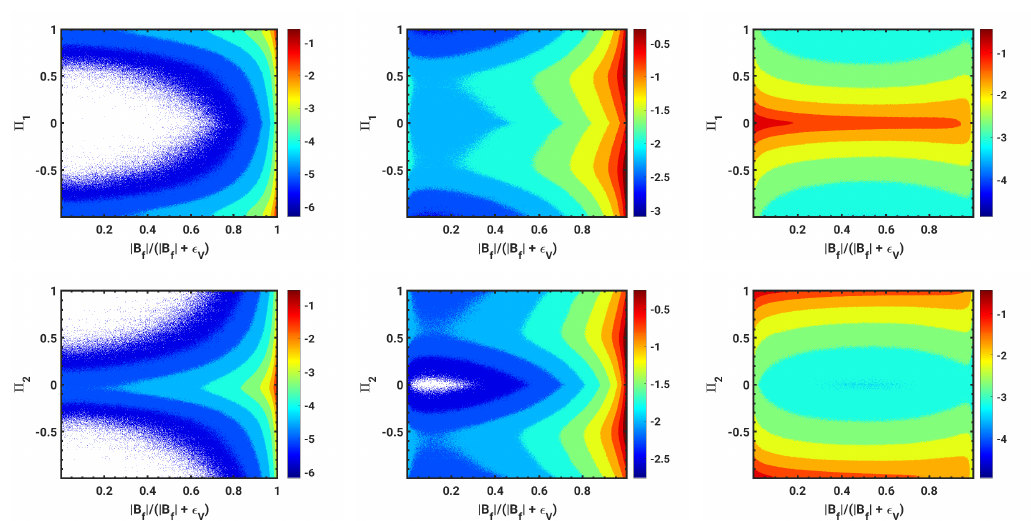
Figure 7. Joint PDFs of normalized linear ( Π 1 , top ) and nonlinear ( Π 2 , bottom ) potential vorticity vs. normalized buoyancy flux, for the same three runs as in the preceding